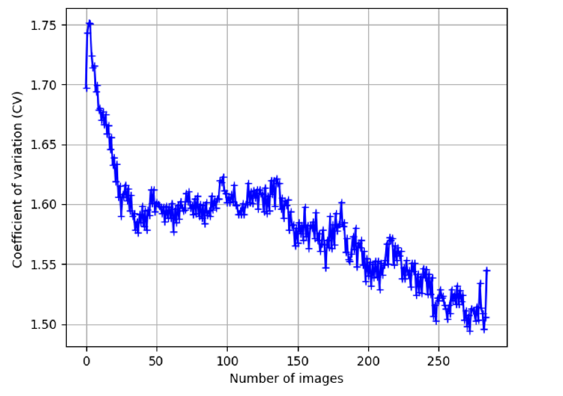
9 of 19 Figure 5. Parameters of the Gabor filter set: 𝑓 = 3.0,𝑠𝑖𝑧𝑒 = 21 , 4 rotations: 𝜃 (cid:2868) = 0 (cid:3042) , 𝜃 (cid:2869) = 45 (cid:3042) , 𝜃 (cid:2870) = 90 (cid:3042) , 𝜃 (cid:2871) = 135 (cid:3042) and 𝛾 = 10, 𝜂 = 0.5 . 3.5.2. Coefficient of Variation and Linear Regression The coefficient of variation is a standardized measure of the dispersion of a probabil- ity distribution or frequency distribution [40]. A mathematical definition for a population of data is presented in Equation (3):